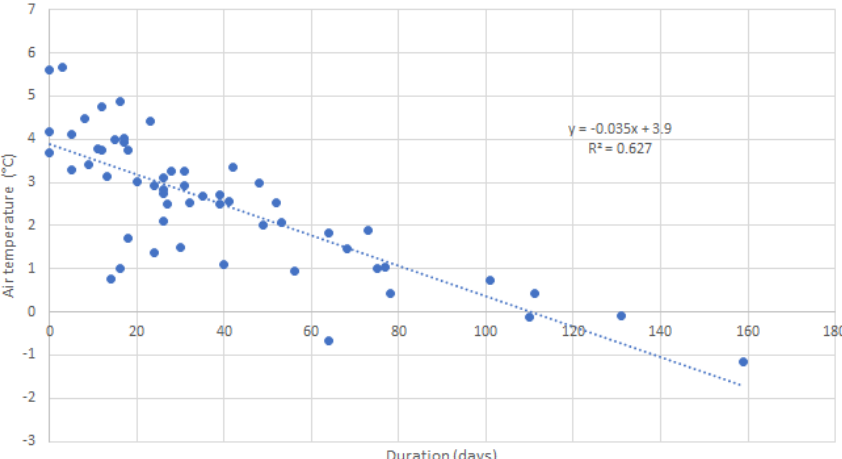
Figure 9. Correlation between average air temperature in the cool half-year (November to April) and duration of the ice phenomena on the Warta River in Pozna ń for the time period 1964–2020